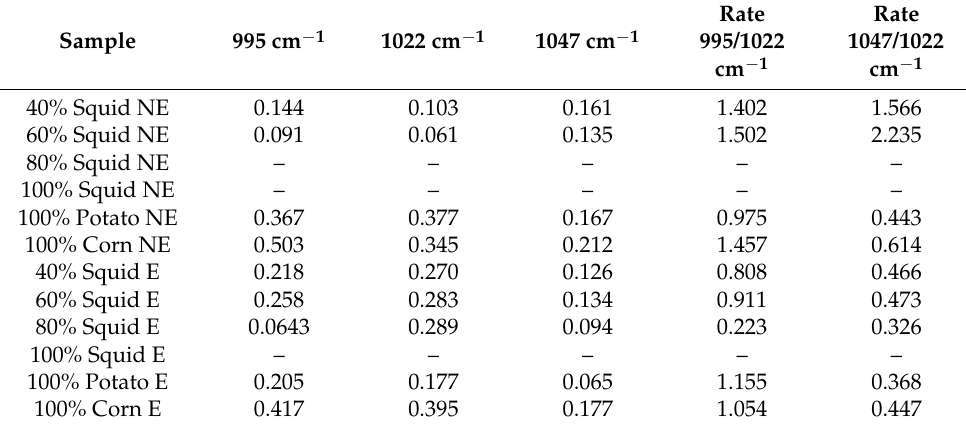
Table 2. Absorbances after the deconvolution of the starch region of the different squid–potato– corn